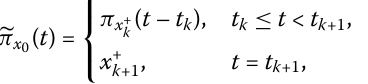
( t ) of (1.1) with the initial condition x 0 ∈ 0